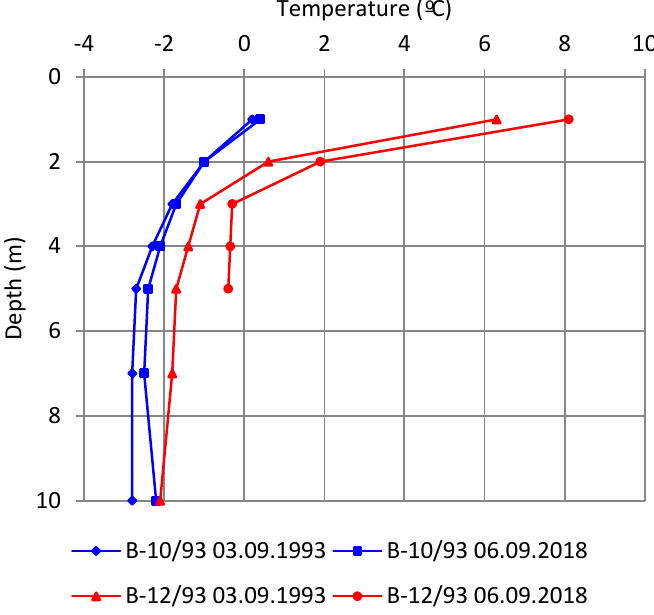
Figure 7. Ground temperature extremes in an undisturbed larch forest (B-10/93) and a water pipeline right-of-way (B-12/93).